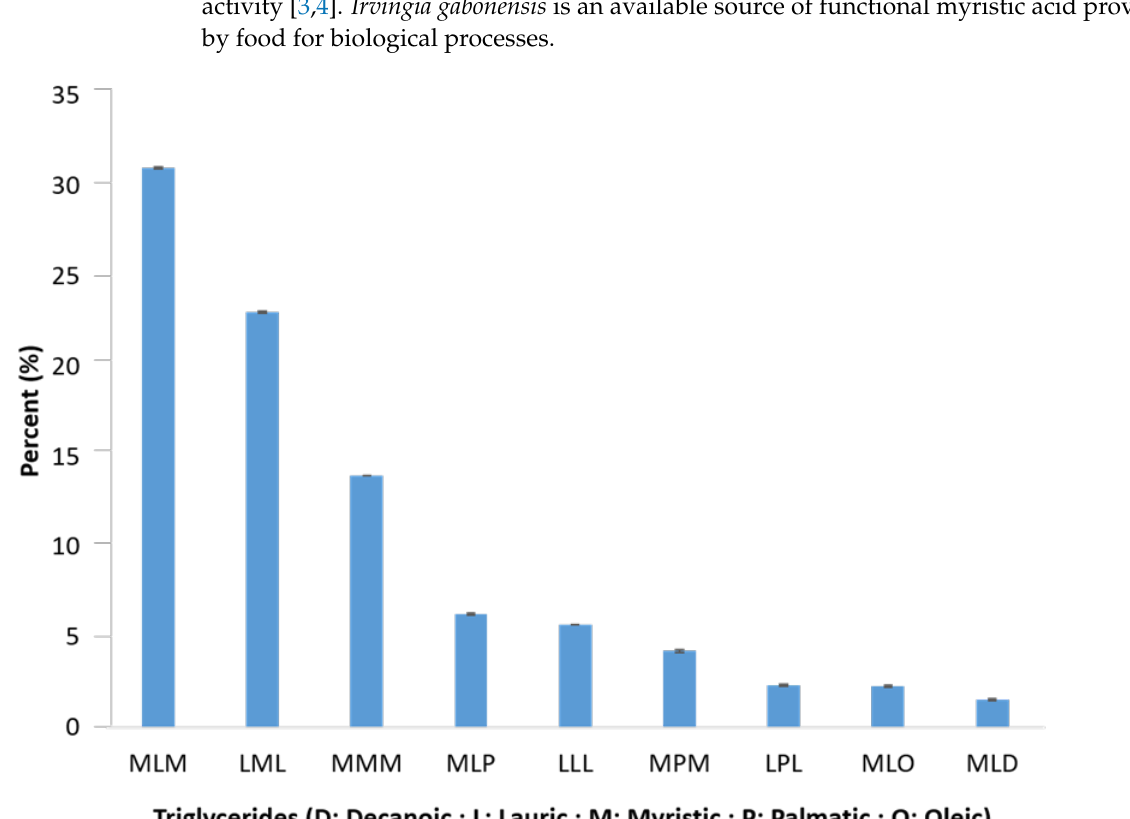
Figure 3. Triglycerides composition observed in almonds of I. gabonensis .